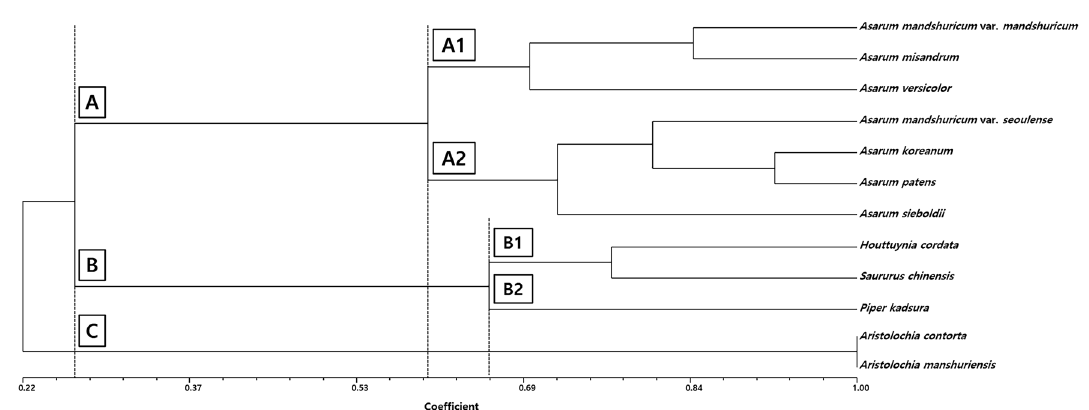
Figure 7. Phenogram for 12 species in the Korean Piperales from cluster analysis based on UPGMA using 13 pollen surface and orbicule palynological characteristics. The vertical dashed line indicates the similarity